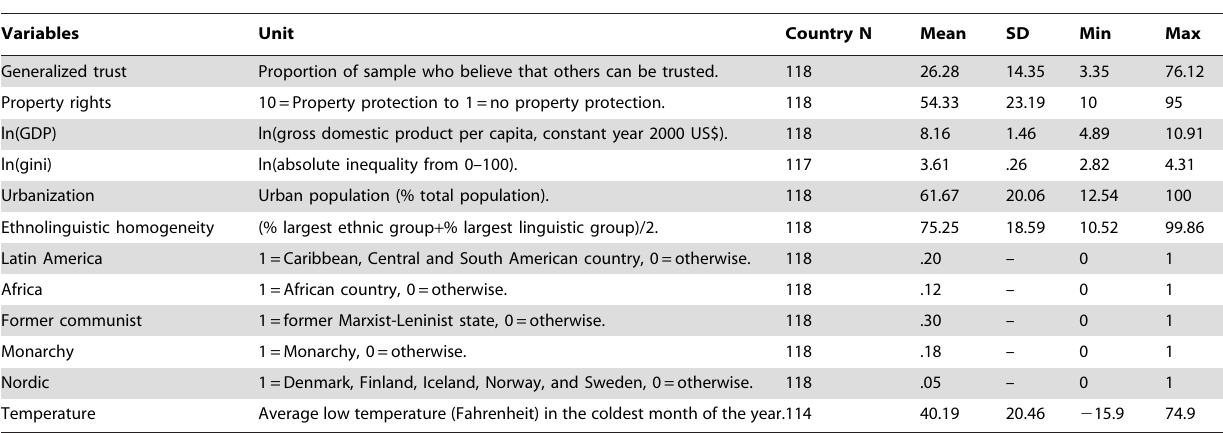
Table 1. Description of variables and summary statistics.